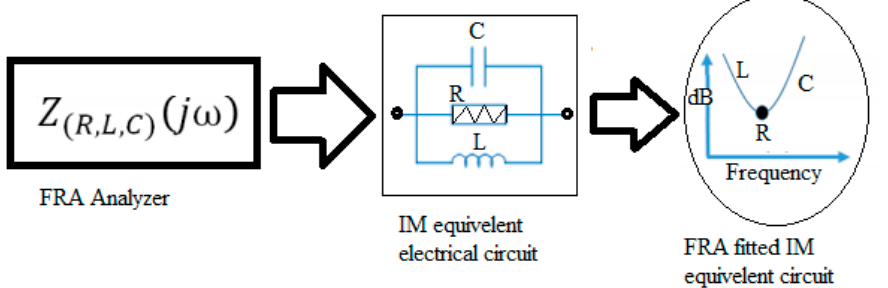
Figure 6. FRA of an equivalent IM RLC electrical circuit.